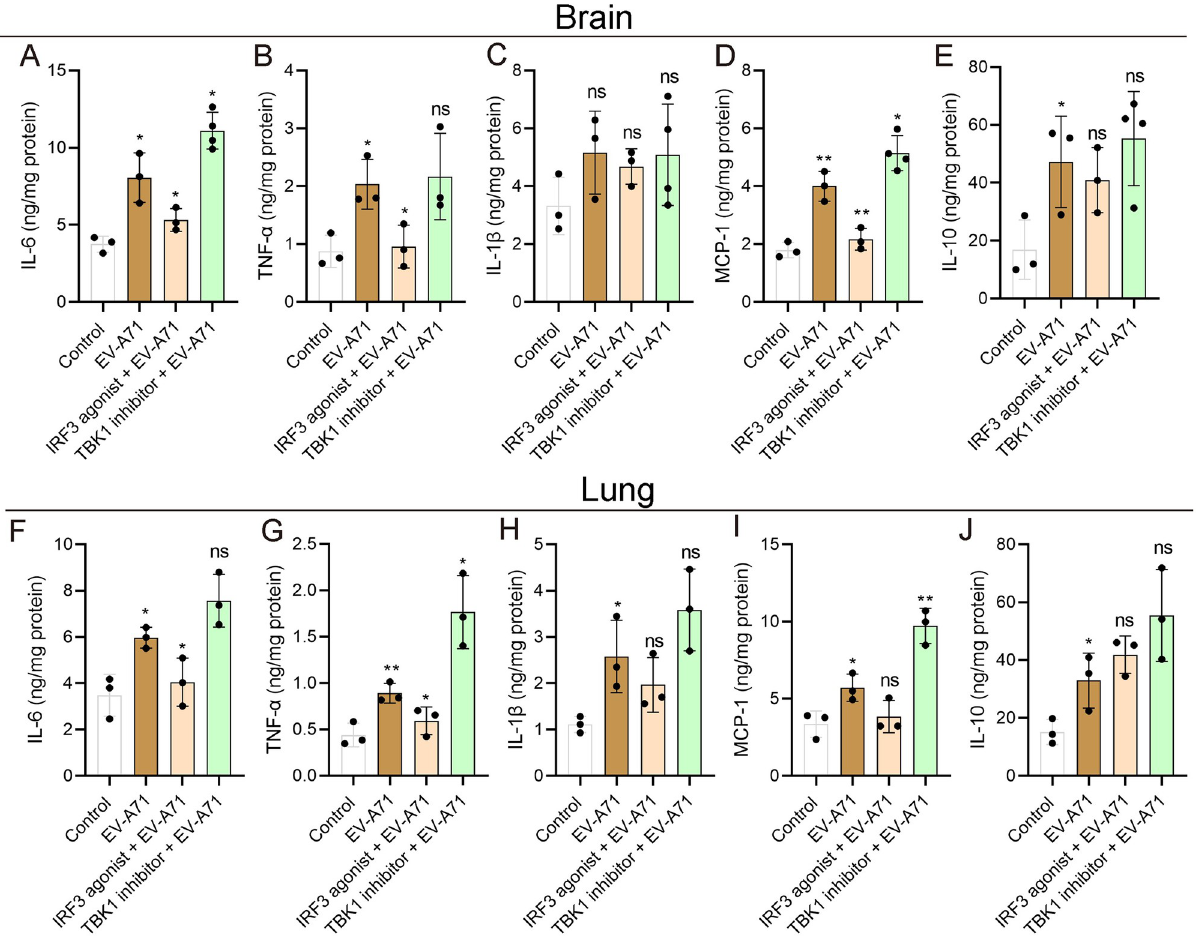
Fig 6. TBK1 and IRF3 interventions on EV-A71-induced proinflammatory cytokines expression in mice. The concentrations of IL-6, TNF- α , IL-1 β , MCP-1and IL-10 in the brains ( A-E ) and lungs ( F-J ) of mice at 5 dpi were determined using ELISA. The data are shown as means ± SD. n = 3 or 4 per group; EV-A71 vs Control; EV-A71-infected mice with TBK1 and IRF3 interventions vs EV-A71-infected mice. � P < 0.05; �� P < 0.01; ns, not significant. All the experiments were repeated at least three times.